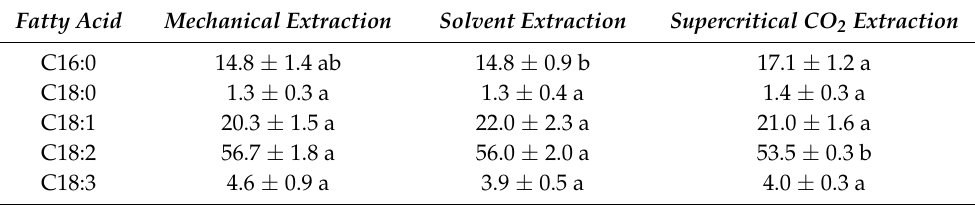
Table 3. Fatty acid composition (%) of WGO extracted with different technologies. Fatty Acid